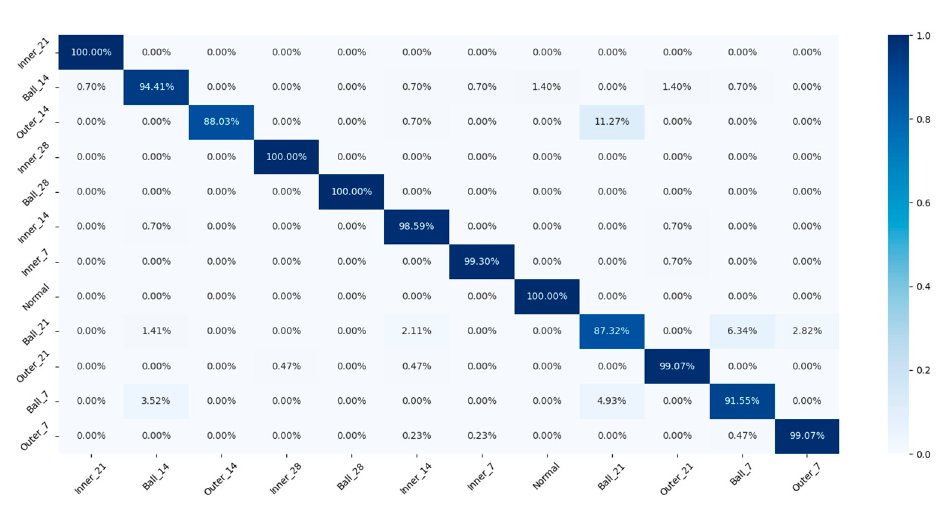
Figure 8. A confusion matrix of vector-CFNN for various sizes of damage diameter classification.